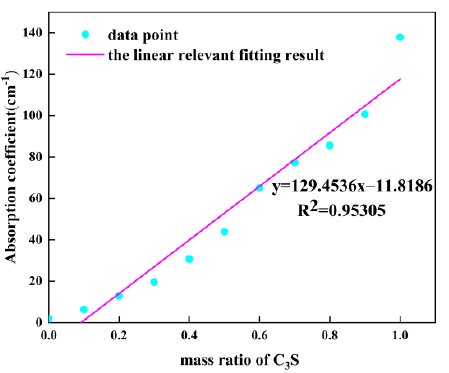
Figure 5 . THz absorption spectra of four groups samples. ( a ) Absorption spectra of Group 1 samples. ( b ) Absorption spectra of Group 2 samples. ( c ) Absorption spectra of Group 3 samples. ( d ) Absorp- tion spectra of Group 4 samples.